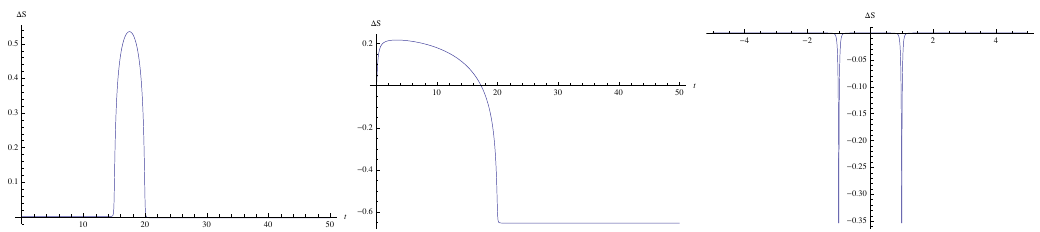
for (cid:11) = 0 : 1. The left graph A